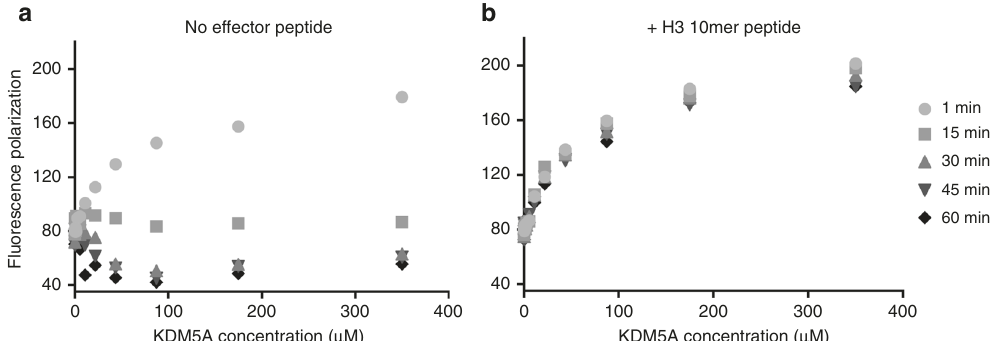
Fig. 3 PHD1 occupation stabilizes substrate binding to the catalytic domain. Change in fl uorescence polarization of C-terminally 5-carboxy fl uorescein (5- FAM) conjugated Ac-H3K4me3 31mer peptide with varying concentrations of KDM5A 1-797 , in the absence ( a ) or presence ( b ) of the H3 10mer effector peptide. Both assays contained 400 µ M MnCl 2 and 400 µ M N-oxalylglycine (N-OG). In panel ( b ), 350 µ M H3 10mer effector peptide